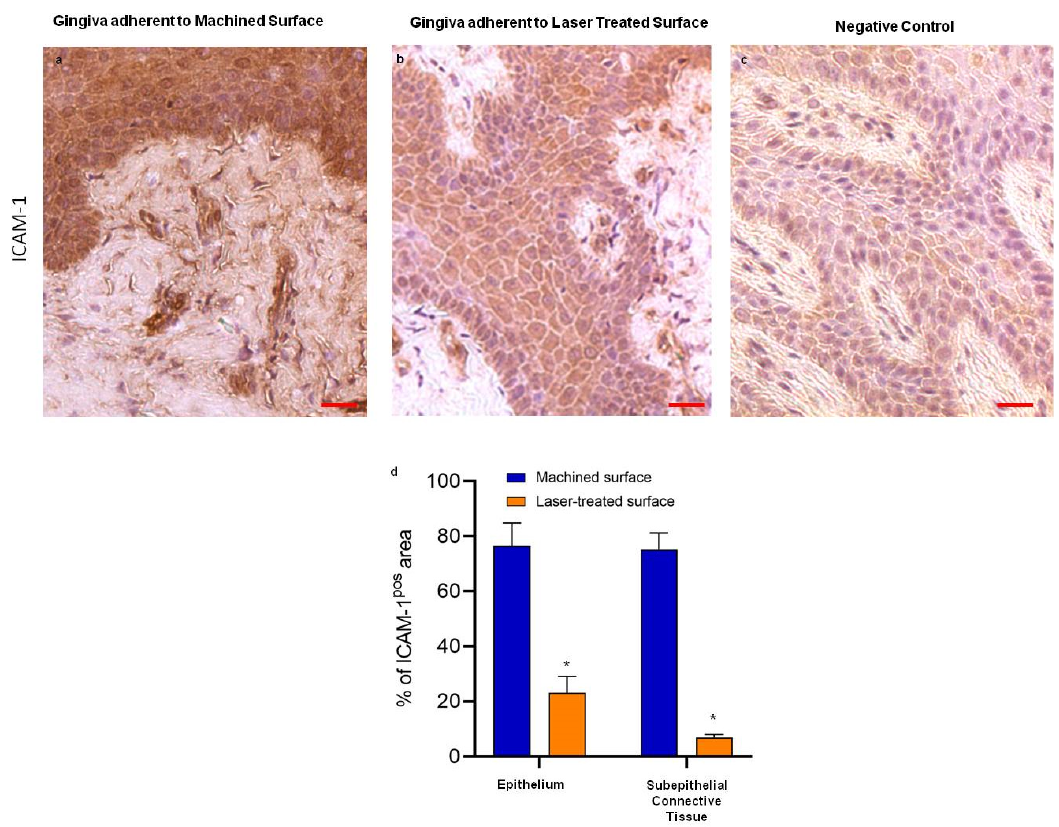
Figure 4. Immunostaining against ICAM-1 of the region of the gingiva adherent to the machined ( a ) and to laser-treated ( b ) surfaces, as indicated. ( c ) represents the negative control. Scale bar: 10 µm. Images are representative of 15 different experiments ( d ) Percentage of ICAM-1 immunostaining positive area in the epithelial layers and subepithelial connective tissue. Values are expressed as mean ± SD of five determinations in randomly chosen sections for each specimen. * indicates values statistically different ( p < 0.001) between the region of the gingiva adherent to the laser-treated or to machined surfaces, as indicated.